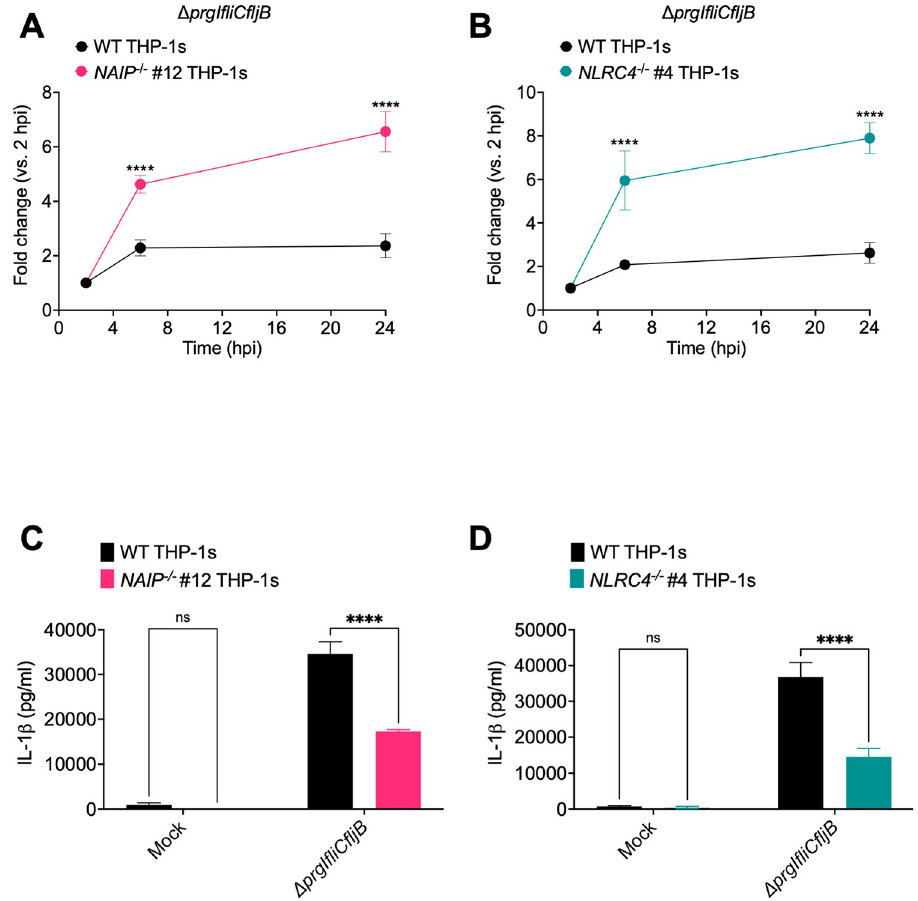
Fig 8. NAIP/NLRC4 inflammasome recognition of the SPI-2 T3SS controls intracellular Salmonella in human macrophages. WT, NAIP -/- , and NLRC4 -/- THP-1 monocyte-derived macrophages were primed with 100 ng/mL Pam3CSK4 for 16 hours. Cells were then infected with PBS (Mock) or Δ prgIfliCfljB S . Typhimurium at an MOI = 20. (A, B) Cells were lysed at the indicated time points and bacteria were plated to calculate CFU. Fold change in CFU/well of bacteria at indicated time point, relative to 2 hpi CFU/well. (C, D) Release of IL-1 β was measured at 24hpi by ELISA. ns–not significant, ���� p < 0.0001 by Sˇı´da´k’s multiple comparisons test.